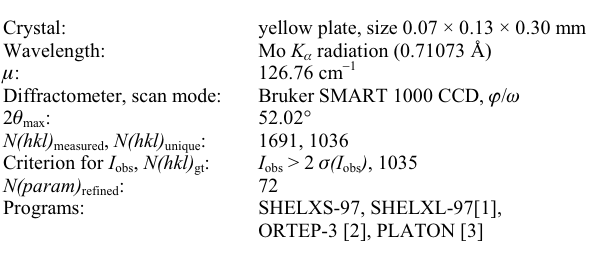
Table 1. Data collection and